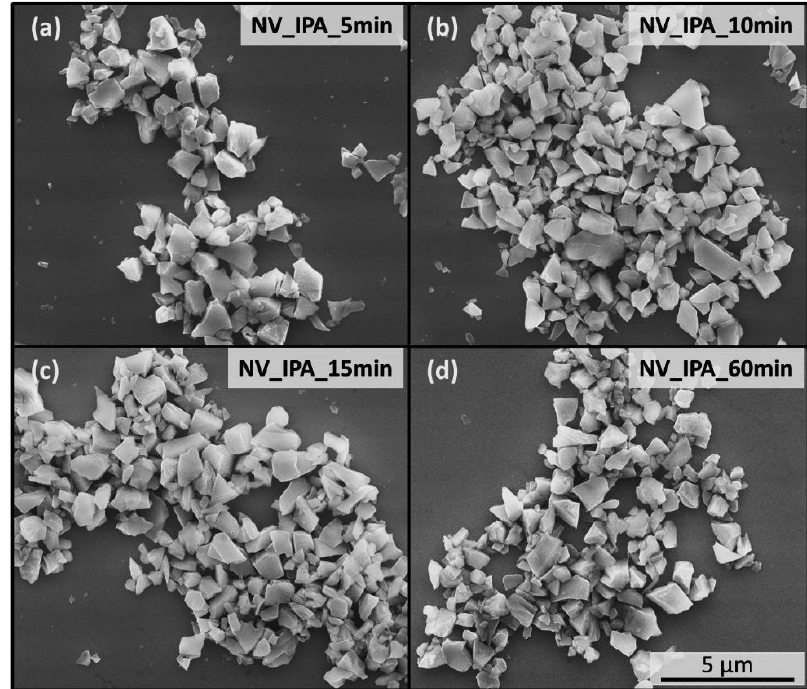
Figure 3. SEM images of the NV-rich nanodiamond particles deposited on silicon substrates after 5 ( a ), 10 ( b ), 15 ( c ), 60 ( d ) min of the ultrasonic disintegration. The most suitable NV-rich nanodiamond particles for use on the AFM tip are coloured blue.